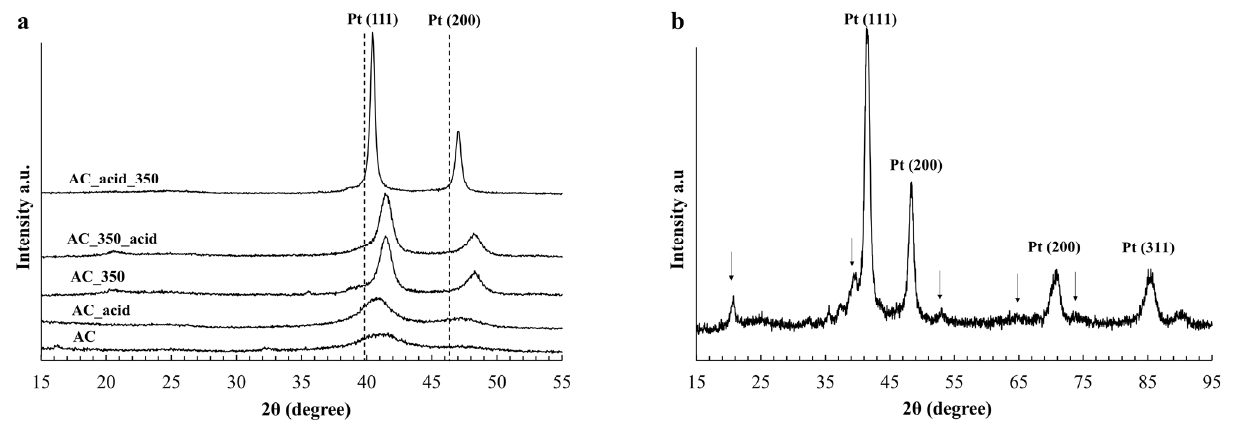
Figure 1. The X-ray diffraction patterns of the obtained PtCu/C samples ( a ); the X-ray diffraction pattern of the AC_350 sample ( b ) indicating the localization of the PtCu intermetallic structure. The composition of the solid solution was estimated according to Vegard’s law